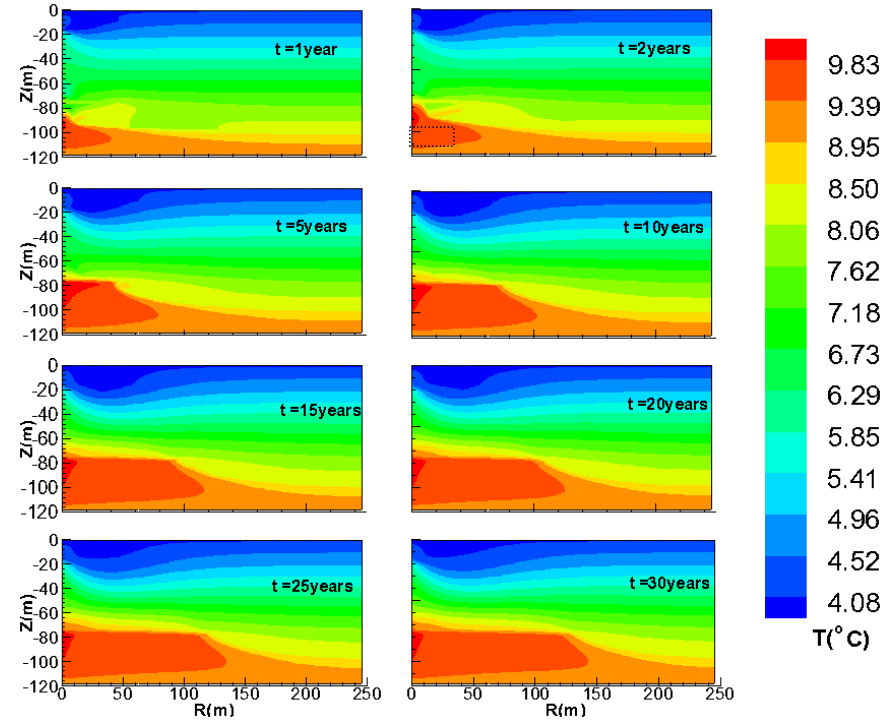
Figure 10. Reference case: evolution of the Temperature ( T) distribution overtime.